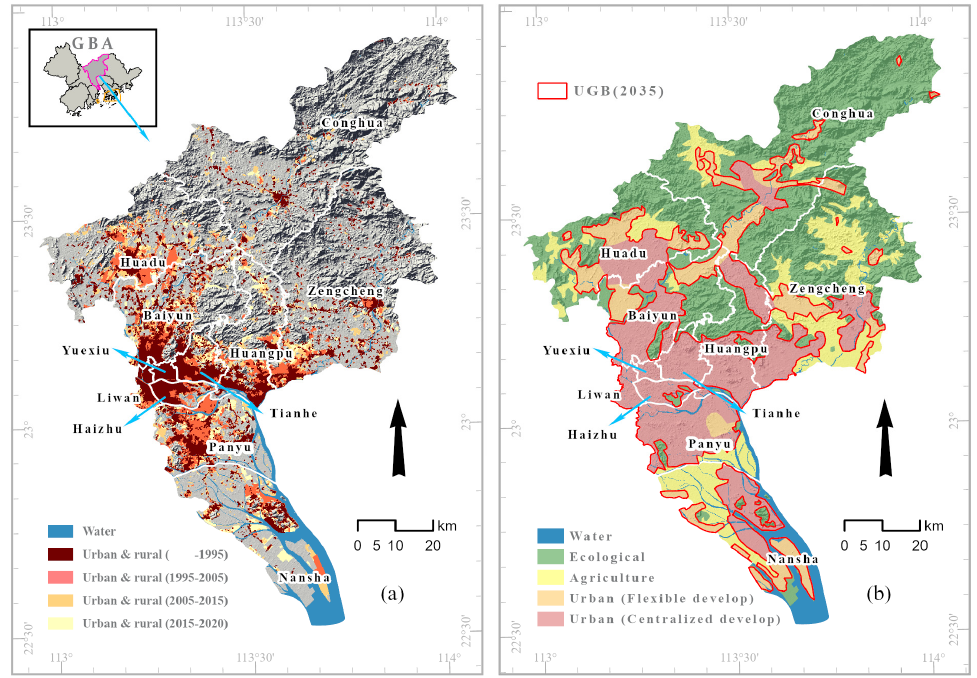
Figure 2. Location of study area and planned UGB for modelling: ( a ) location of Guangzhou and urban growth from 1995–2020; ( b ) urban, agriculture and ecological space planned by agency.